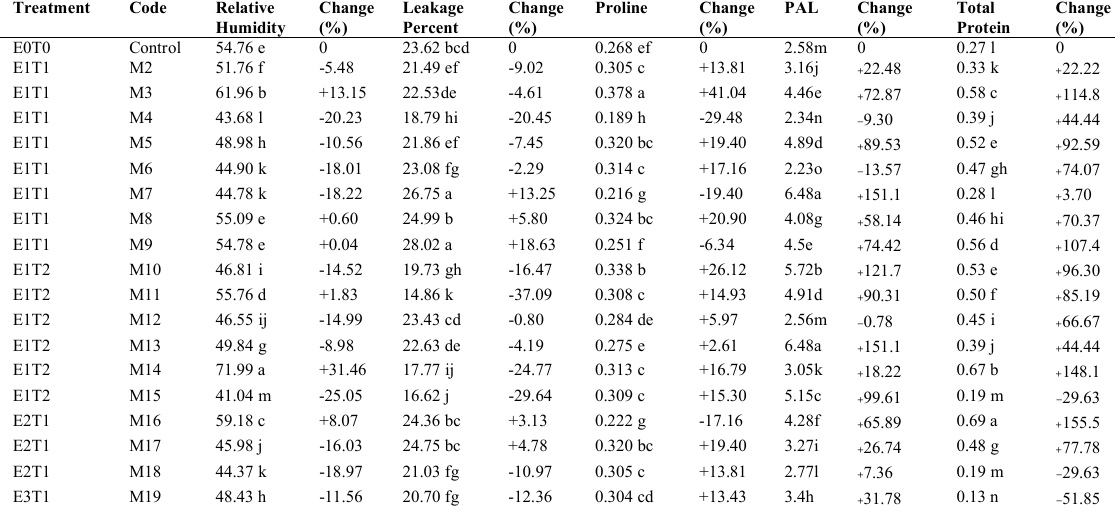
Table 4 . Mean comparison of phytochemical properties of some enzymes in samples treated by EMS Treatment Code